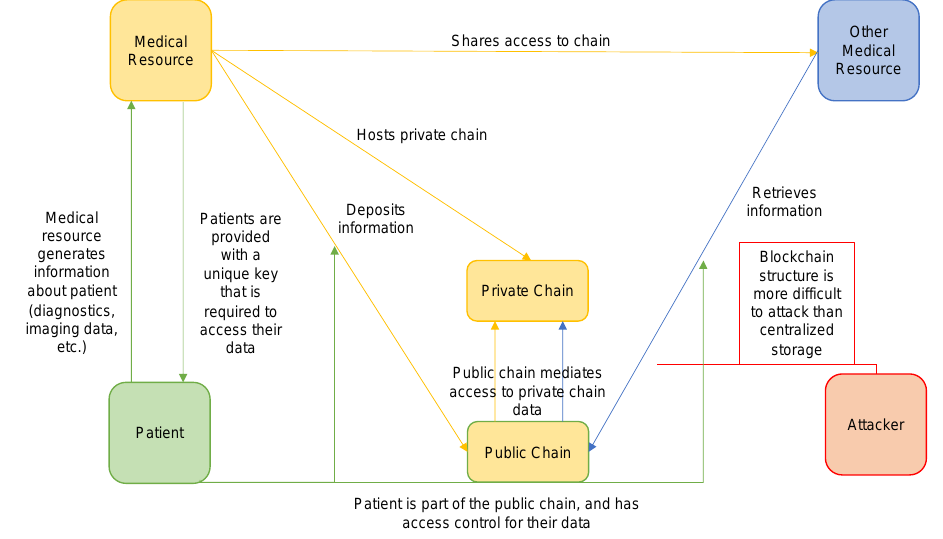
Figure 3. Summary of Blockchain Proposal. A successful blockchain implementation of an EHR system could provide a more secure and patient-privacy-oriented network, that gives patients confidence in the confidentiality of their information and diagnosis.